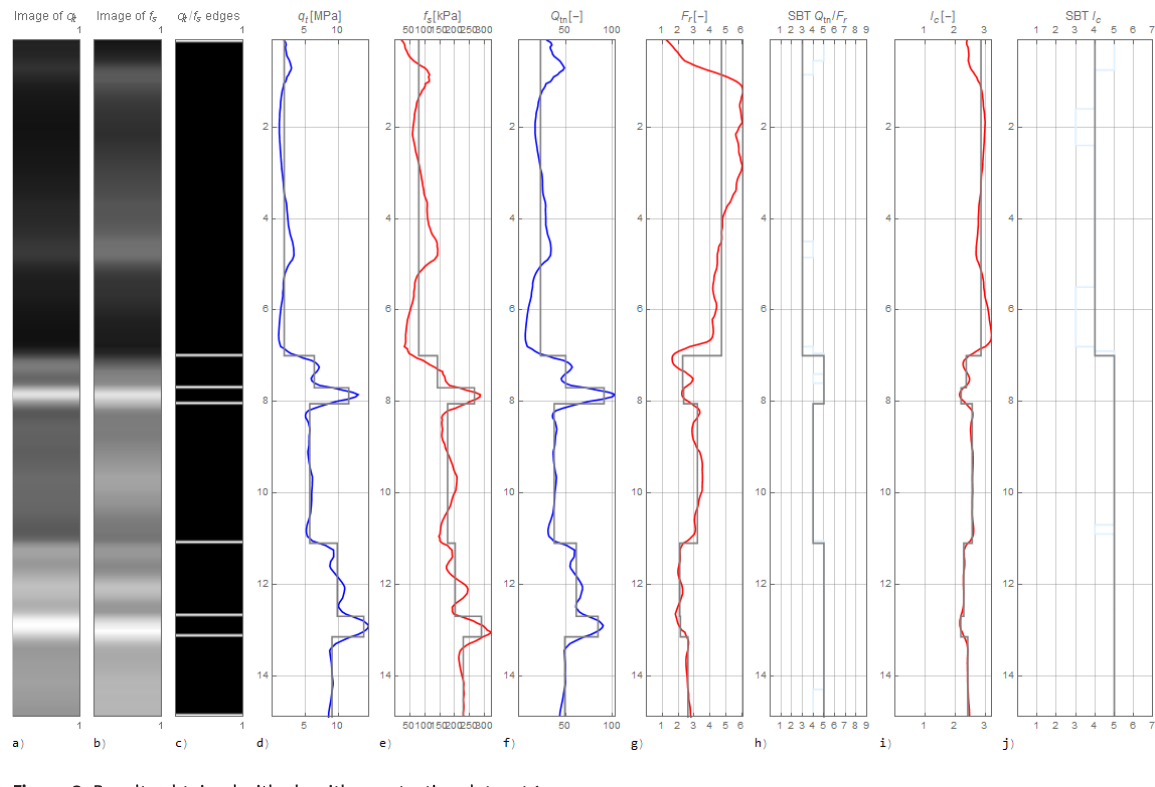
Figure 8: Results obtained with algorithm on testing dataset 1.